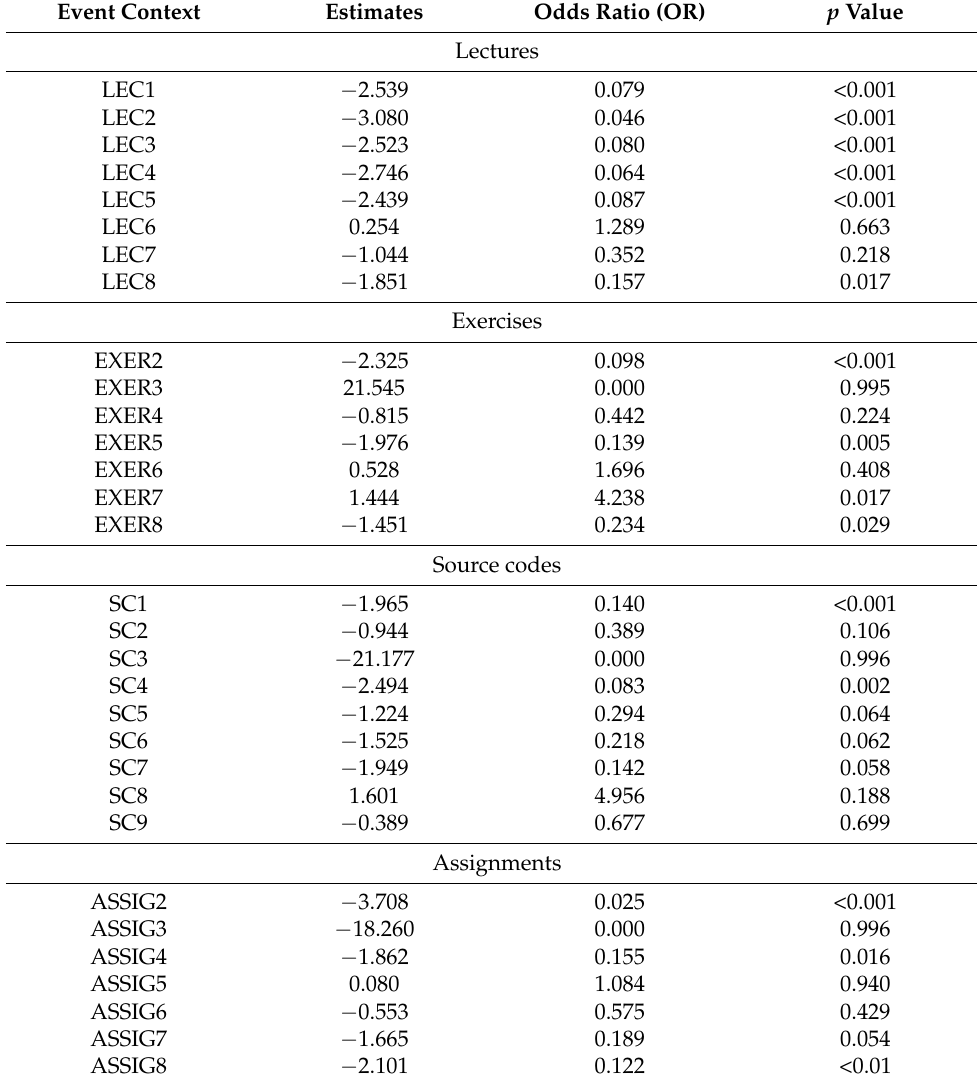
Table 4. Maximum likelihood estimates of logistic regression model.